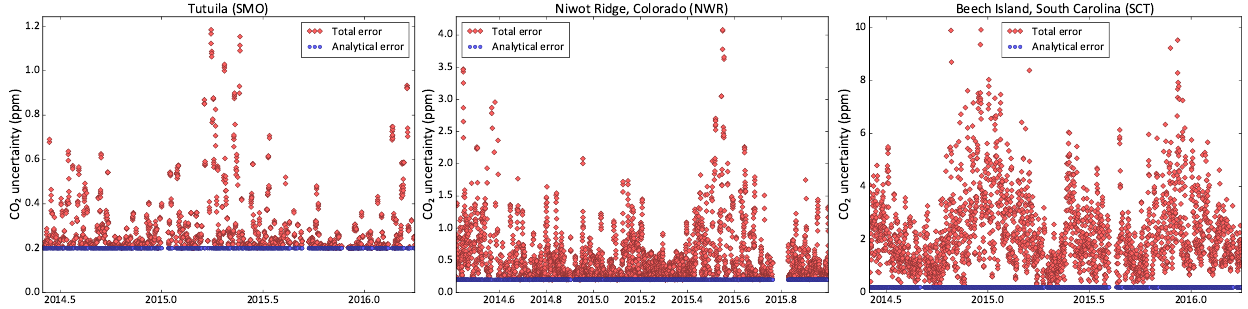
Figure 2. Analytical (blue) and total (red) uncertainty of in situ measurements in the S (cid:15) matrix at three example sites, at times of actual CO 2 measurements. SMO is a remote marine boundary layer site with little model variability, while LEF and WKT are continental sites with significant model